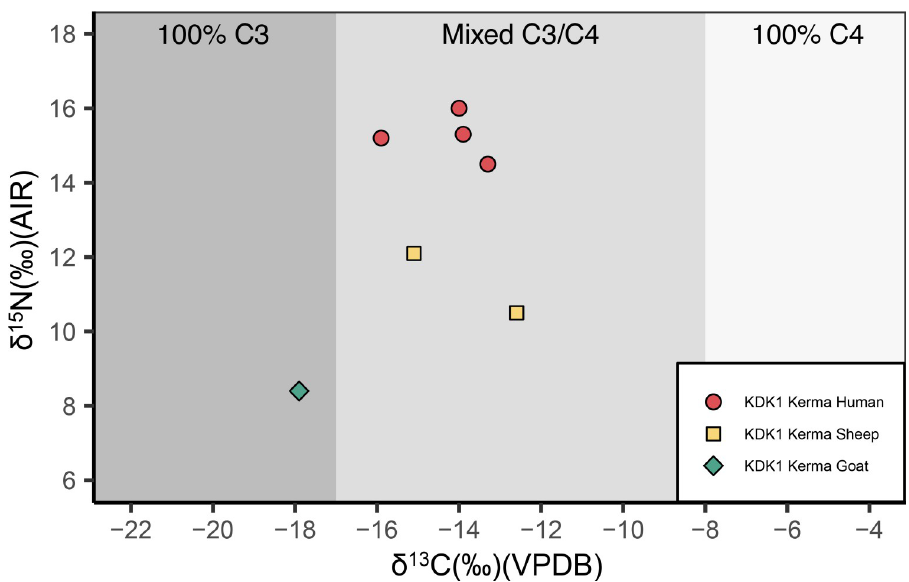
Fig 13. δ 13 C and δ 15 N measurements of human tooth dentine and faunal bone collagen from KDK1, Kerma period. Shading indicates estimated collagen δ 13 C for individuals consuming 100% C 3 , mixed C 3 /C 4 , and 100% C